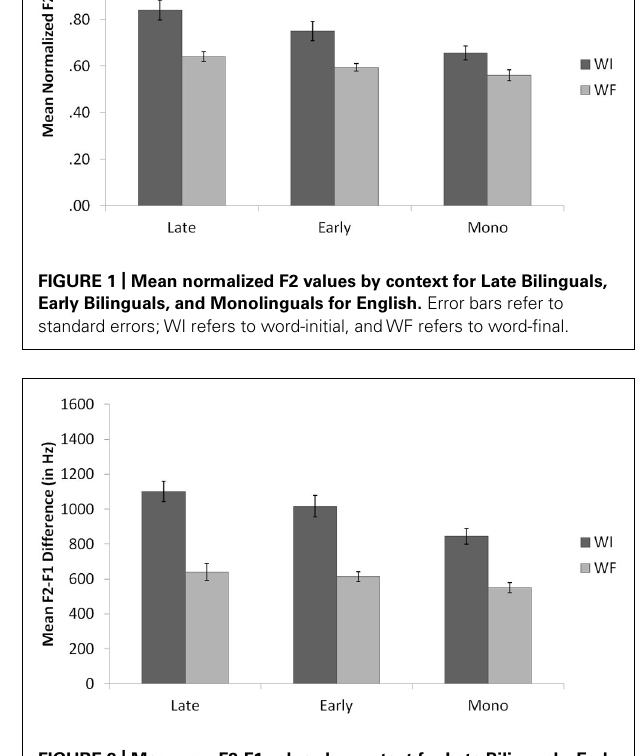
FIGURE 2 | Mean raw F2-F1 values by context for Late Bilinguals, Early Bilinguals, and Monolinguals for English. Error bars refer to standard errors.